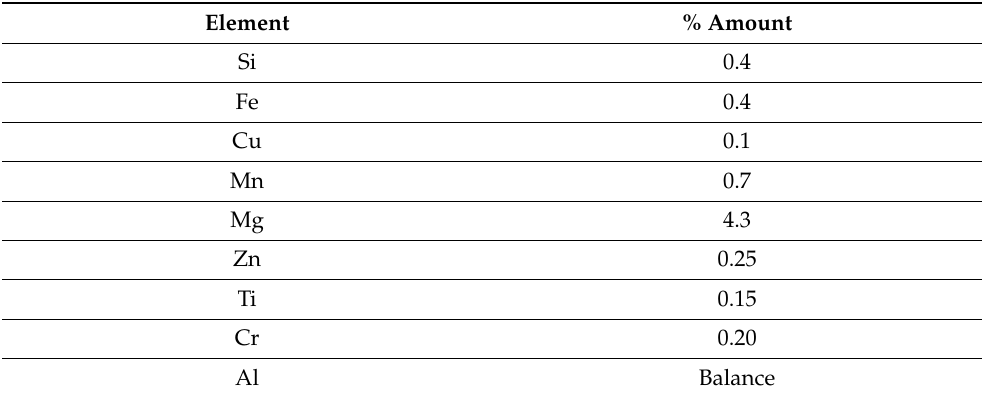
Table 1. Chemical composition of Al5083 alloy.